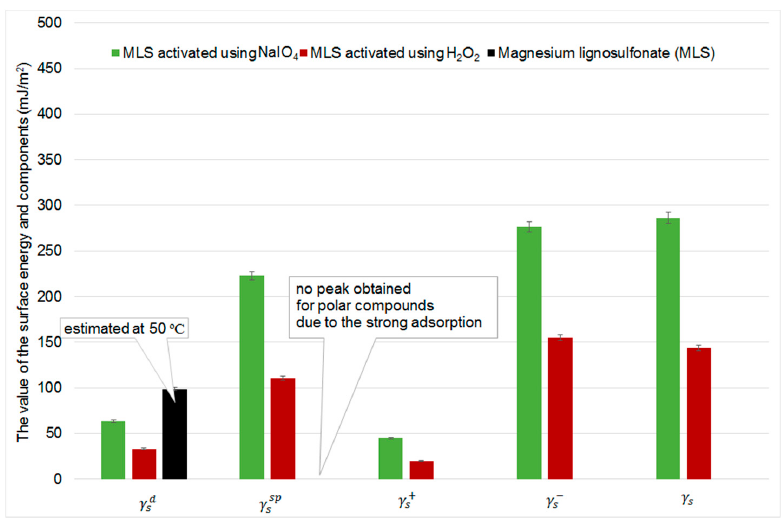
Figure 8. Surface free energy and its components for lignosulfonate samples.